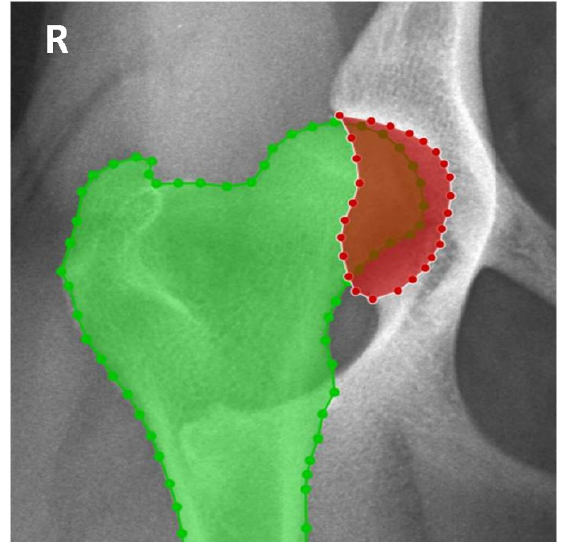
Figure 2. Delimitation of the proximal femur and acetabulum using the LabelMe annotation tool for the calculation of Hip Congruence Index (HCI). The acetabular area (AA) is delimitated by red points represented in red. The proximal femur is delimitated by green points and represented in green. The acetabular area occupied by the femoral head (AAOFH) is represented by the overlap between the red and green areas (HCI = AAOFH/AA). R—right side.